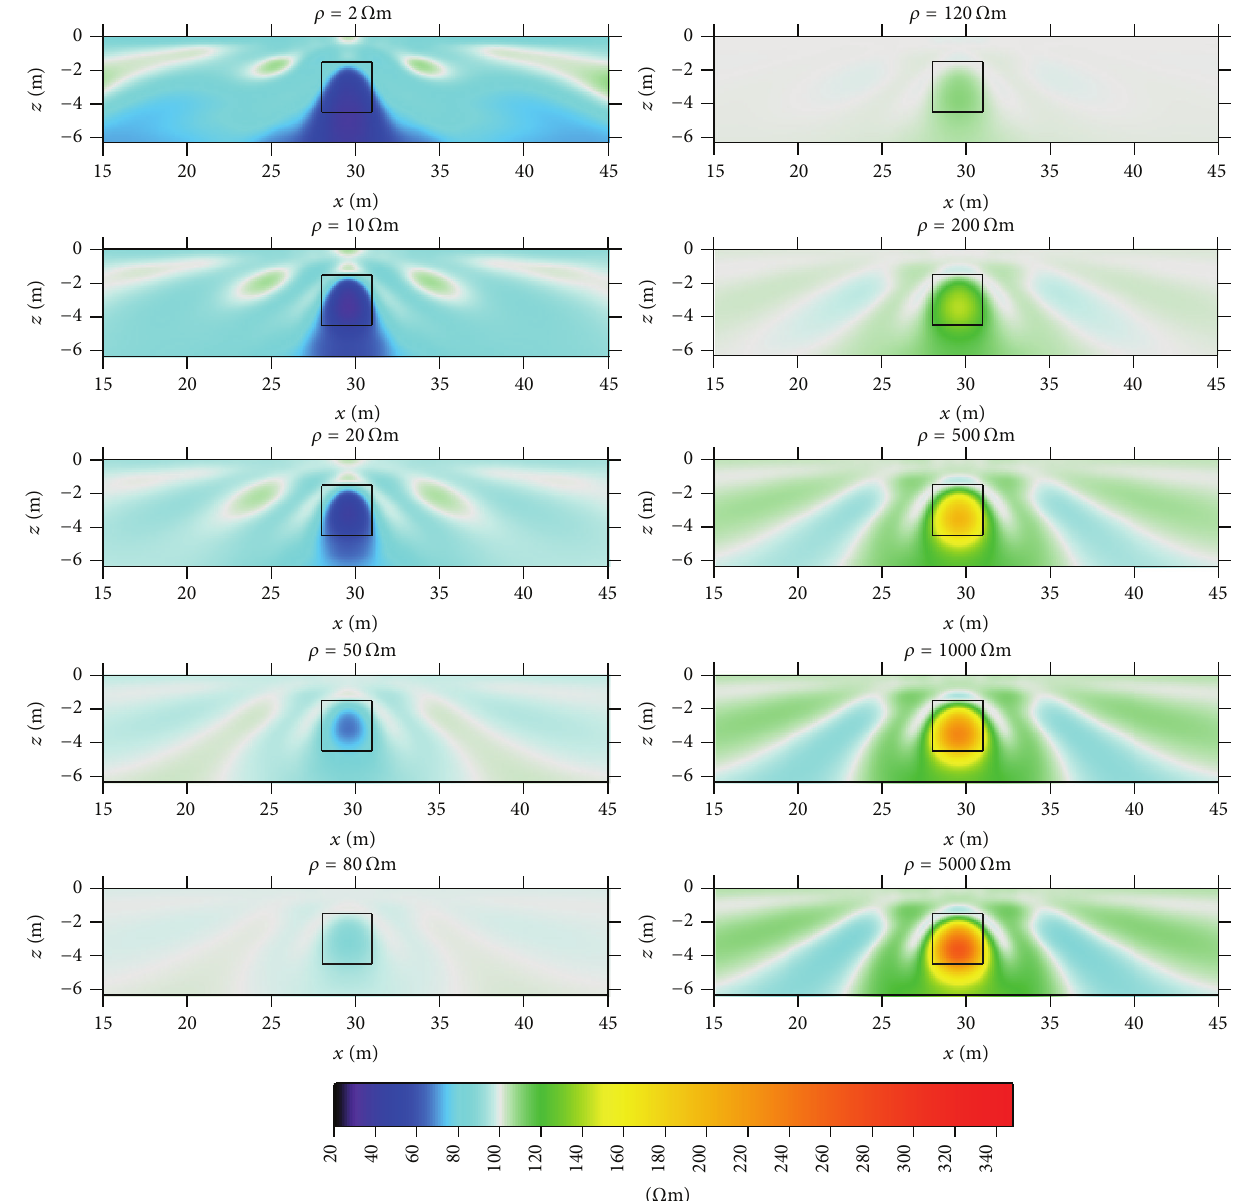
Figure 7: Results of filtered Jacobian damped LSQR imaging obtained by varying the resistivity of an anomalous square body, buried in a homogeneous medium (100 Ω m), from 2 Ω m to 5000 Ω